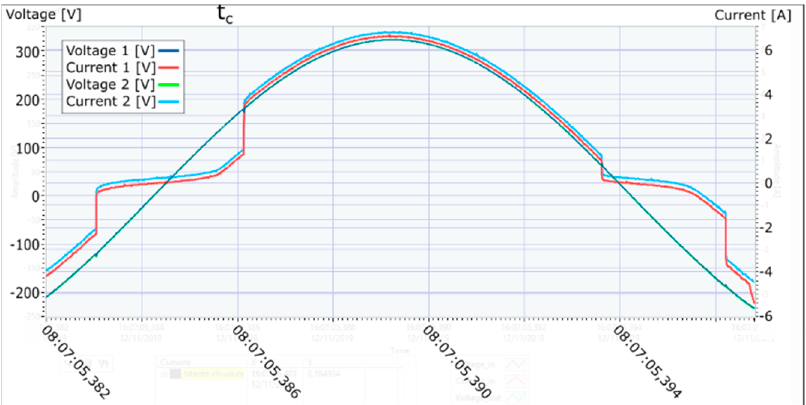
Figure 17. Instant ( t e ) at which the circuit was opened by the AFDD (using the Bourns 2049-23 surge arrester).